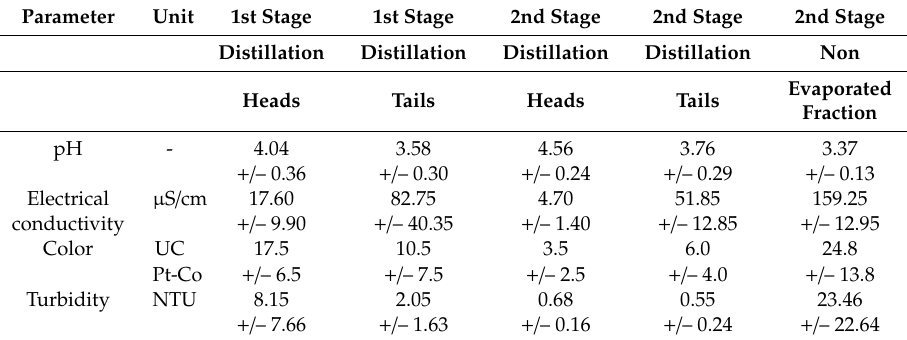
Table 4. pH, conductivity, color, and turbidity